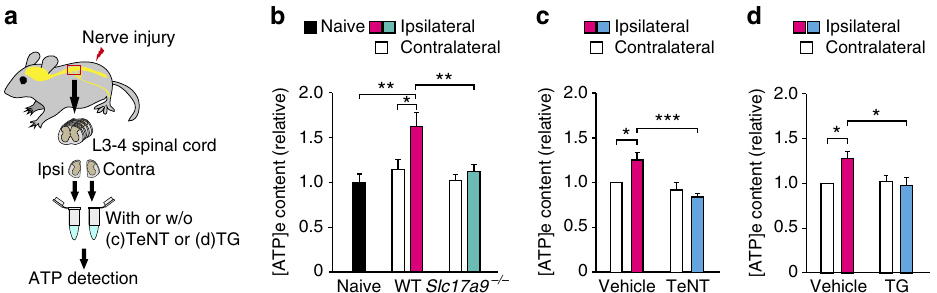
Figure 1 | PNI-induced increase in extracellular ATP within the spinal cord is dependent on VNUT. ( a ) Schematic diagram of the experimental protocol for spinal ATP detection (Ipsi, ipsilateral; Contra, contralateral). ( b ) Measurement of extracellular ATP ([ATP] e ) content in the ACSF media of ipsilateral and contralateral spinal cord slices taken from wild-type (WT) and VNUT-deficient ( Slc17a9 (cid:2) / (cid:2) ) mice before (naive) and 7 days after PNI (naive: n ¼ 12, WT and Slc17a9 (cid:2) / (cid:2) : n ¼ 16; * P o 0.05, ** P o 0.01, one-way ANOVA with post hoc Tukey Multiple Comparison test). ( c , d ) Measurement of [ATP] e content in the ACSF media of ipsilateral and contralateral spinal cord slices taken from WTmice with or without (w/o) ( c ) tetanus toxin (TeNT) or ( d ) thapsigargin (TG) 7 days after PNI ( c : n ¼ 6, d : n ¼ 11; * P o 0.05, *** P o 0.001, one-way ANOVA with post hoc Tukey Multiple Comparison test). Values are means ± s.e.m.